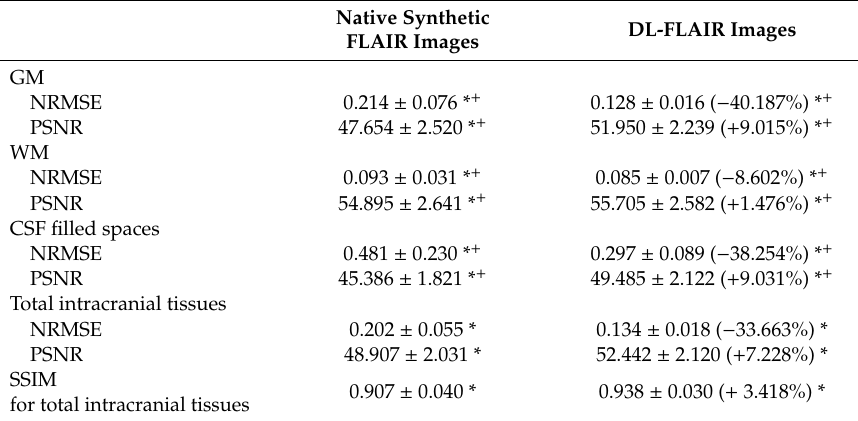
Figure 5. Representative case of preservation of true sulcal lesion in patient with brain and leptomeningeal metastases from lung cancer. Leptomeningeal metastases showing sulcal hyperintensity (arrows) on the native synthetic FLAIR ( a ) are preserved on DL-FLAIR ( b ), whereas surface hyperintense artifacts on the native synthetic FLAIR (arrowheads on a) are removed on DL-FLAIR image ( b ). The leptomeningeal metastases are conspicuously delineated on 3D-FLAIR ( c ), and the corresponding lesions show prominent enhancement on Gd-enhanced FLAIR ( d ) and Gd-enhanced 3D T1-weighted image ( e ). Table 2. NRMSE, PSNR, and SSIM of native synthetic FLAIR and DL-FLAIR images against conventional 2D FLAIR images in various regions in 19 patients.